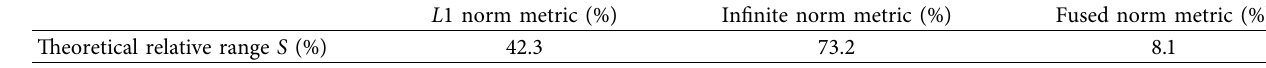
Table 1: Theoretical relative ranges of each norm